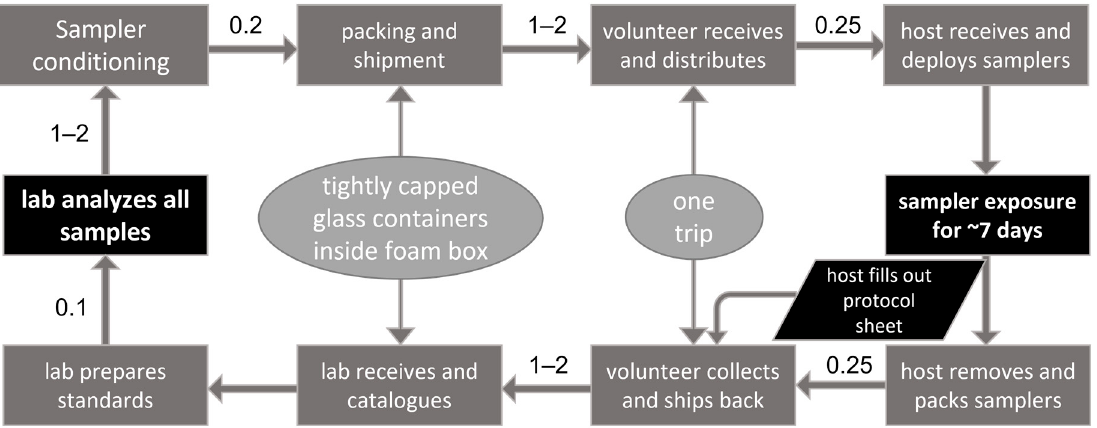
Figure 1. Flowchart of Radiello ® hydrocarbon passive sampler turnaround. Individual process steps are outlined inside grey rectangles, critical steps inside black rectangles. Oval connectors provide background information on two intermediate steps each. A data input step provided in the field is outlined by a black rhombus. Numbers alongside the progress arrows provide the approximate times in days between the process